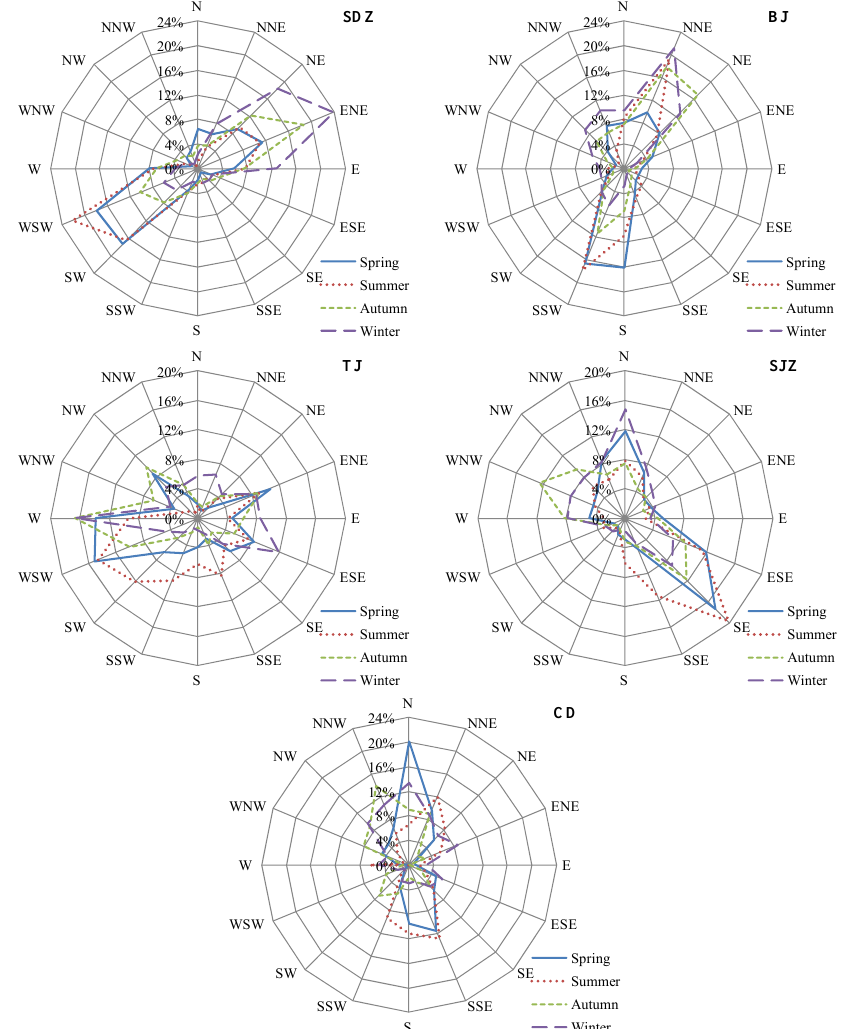
Figure 2. Wind roses of all four sampling periods at each site. Fig. 2. Wind roses of all four sampling periods at each